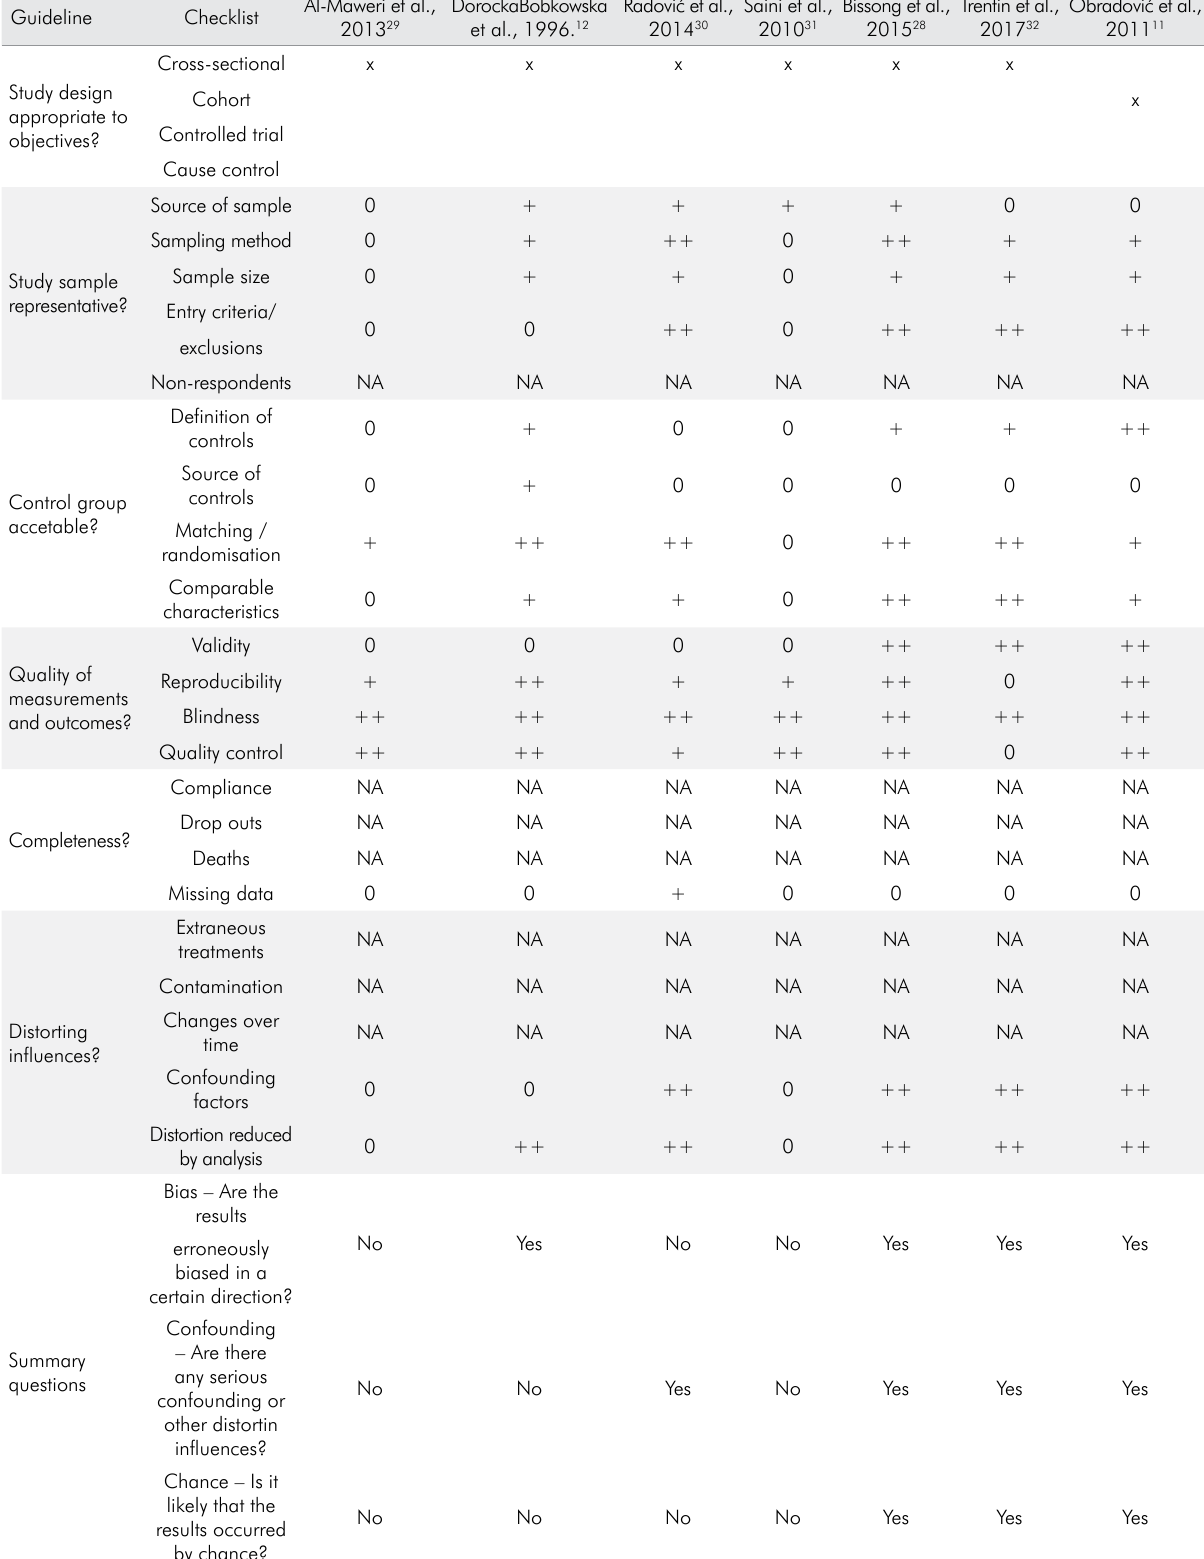
Table 3. Quality assessment based on Fowkes and Fulton (1991). Guideline Checklist Study design appropriate to objectives?